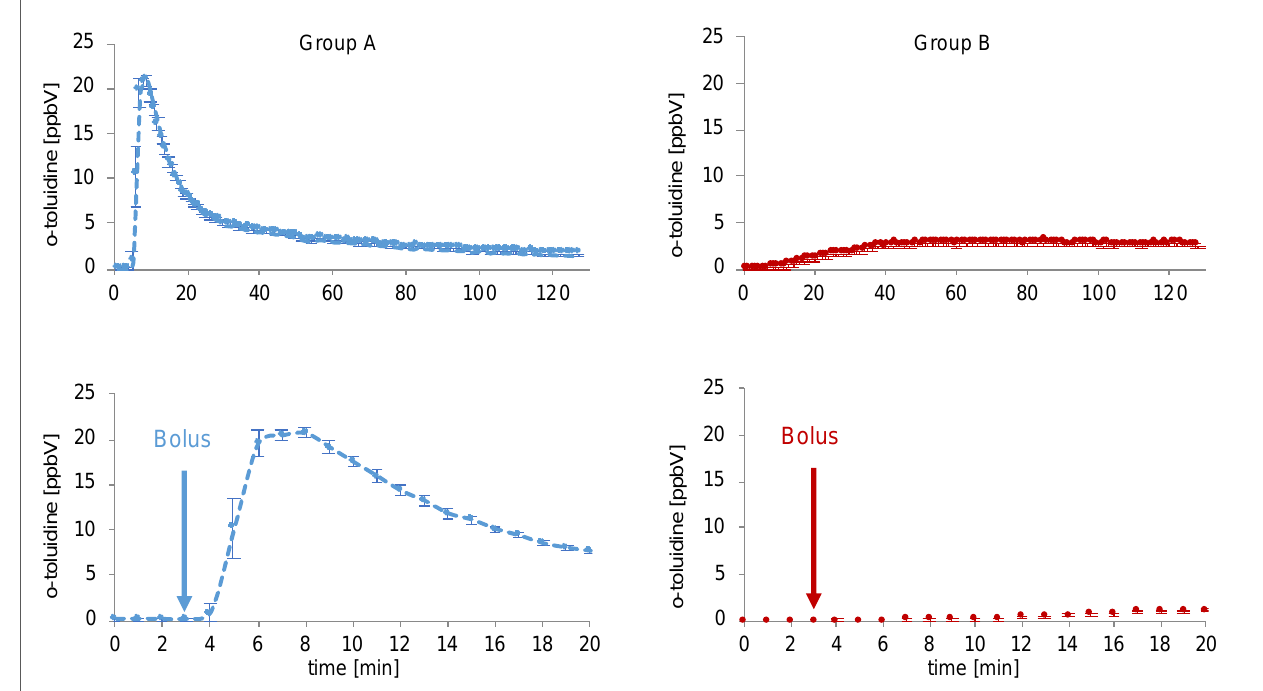
Figure 1. Time course of haemodynamic parameters mean arterial pressure (MAP) and cardiac out- put (CO). Blue lines represent group A (intravenous injection of prilocaine, n = 6) and red lines represent group B (cervical plexus regional anaesthesia with prilocaine, n = 5). Dots mark the de- fined measurement points as mean value of the entire group with relevant SD values.